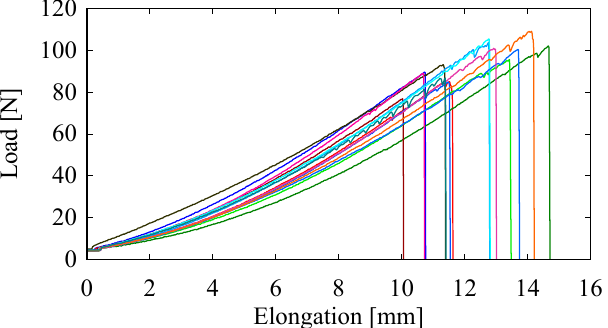
Figure 4. Load versus elongation plots of jute yarn specimens.